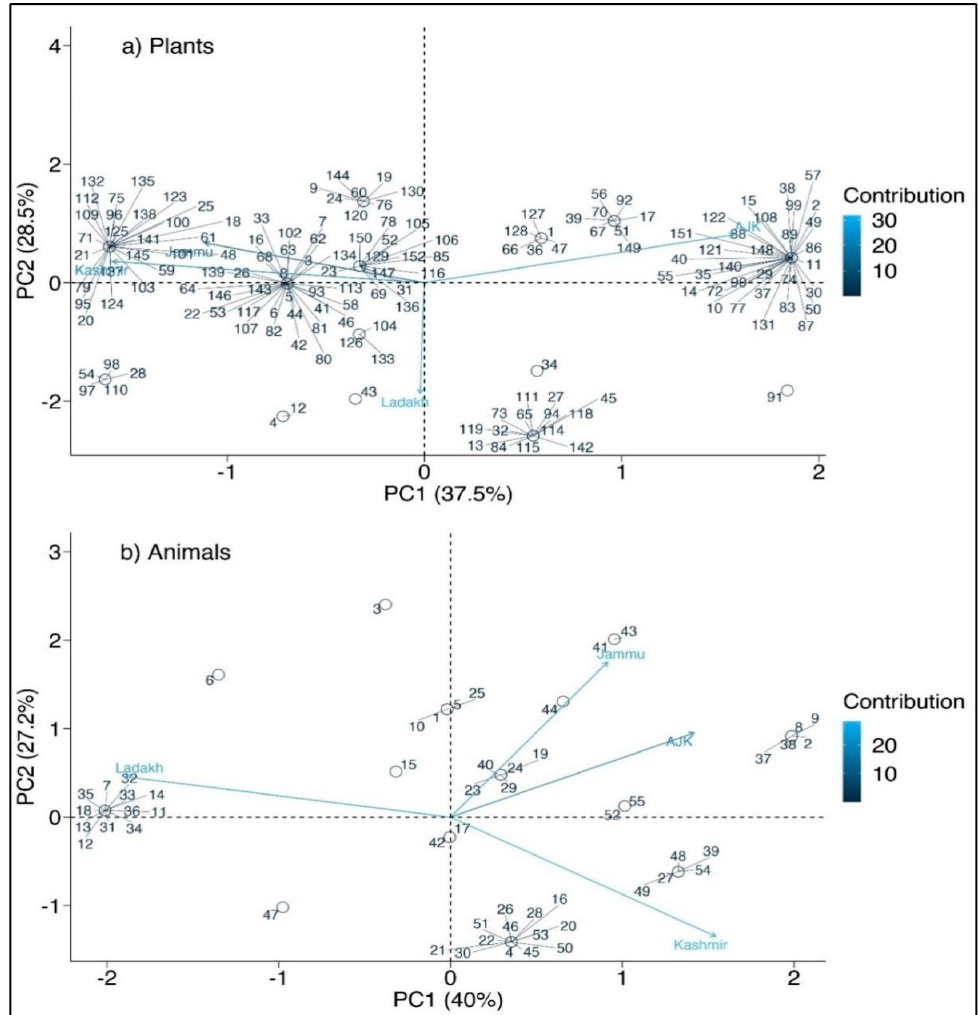
Figure 8. PCA diagram ( a ) representing clustering of plant species ( b )representing clustering of animal species among different regions. The complete name of species as per the serial numbering in Table S1.